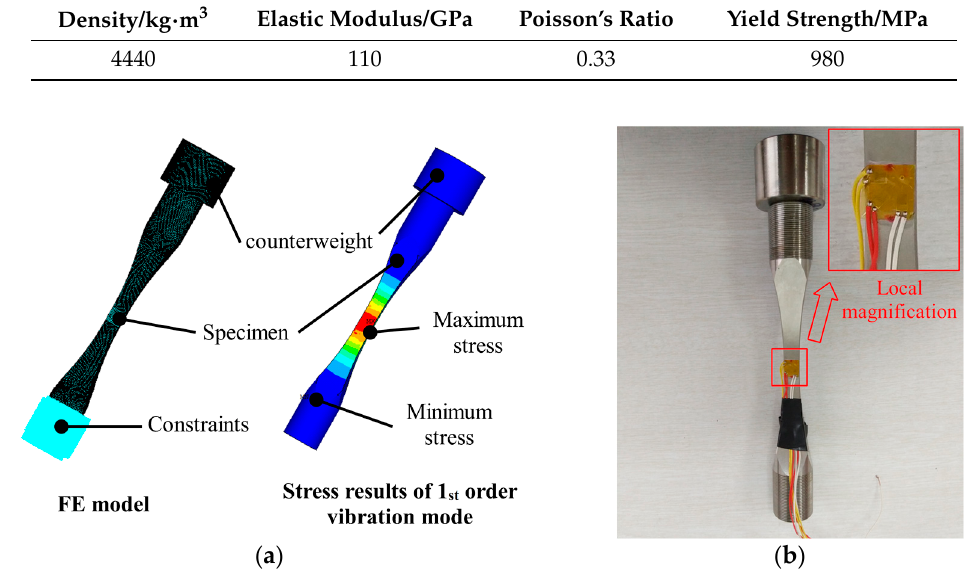
Table 1. Mechanical properties of the Ti-6Al-4V titanium alloy.